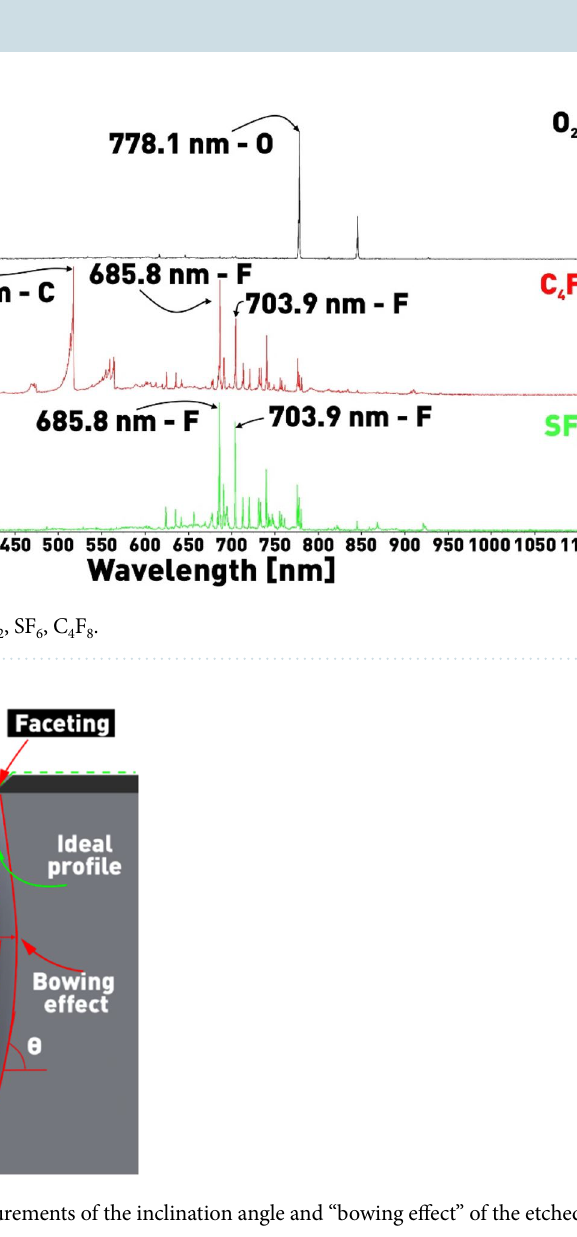
horizontal or vertical (sidewalls) surfaces 28,30,31 . As a result, the etched window grows in cross-sectional dimen-